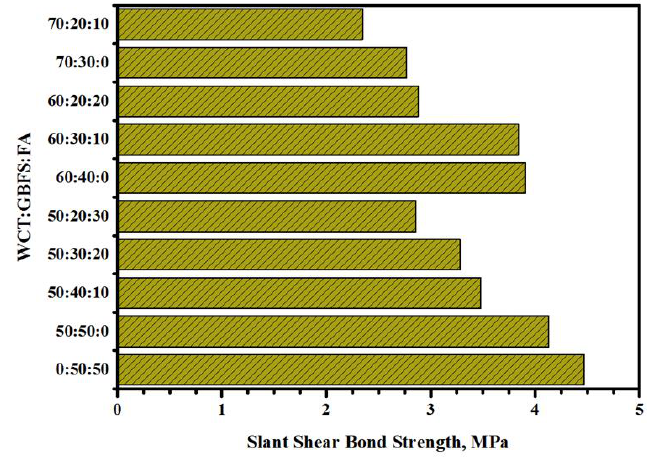
Figure 2. Effects of various WCT:GBFS:FA on SSBS of GPMs at 28 days of age.